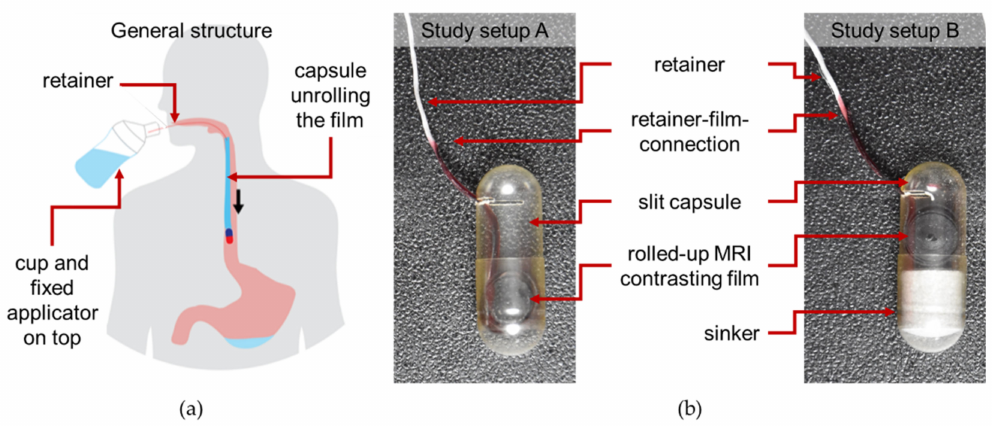
Figure 1. Structure and functionality of the EsoCap system tested. ( a ) General structure of the entire system, with the drinking cup and applicator fixed to it. The retainer attached to the applicator and, at the other end, to the film triggers unrolling of the film from the capsule. ( b ) Study setup A: Slit capsule (size 00) filled with a rolled hibiscus tea contrasting PVA film. Study setup B: A sinker-extended EsoCap system to increase the system’s density was intended to improve